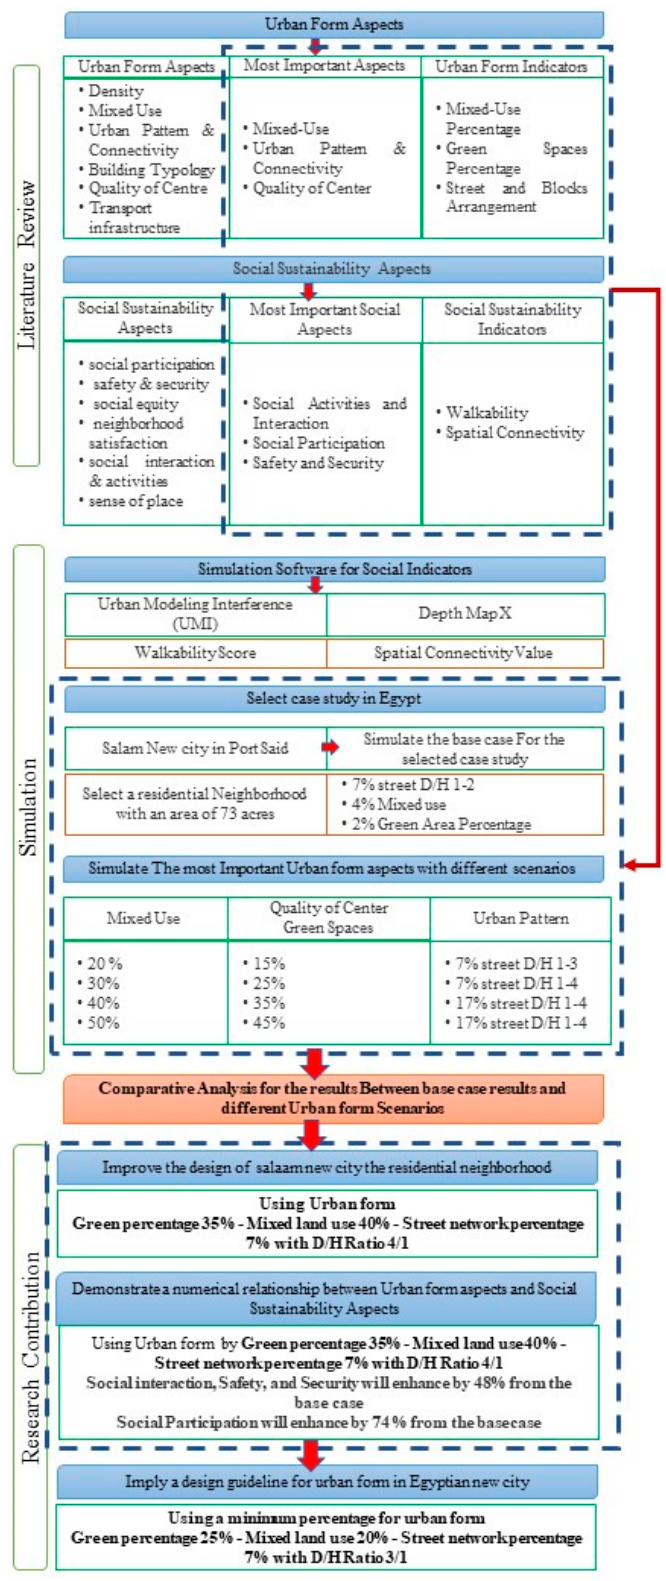
Figure 2. The research